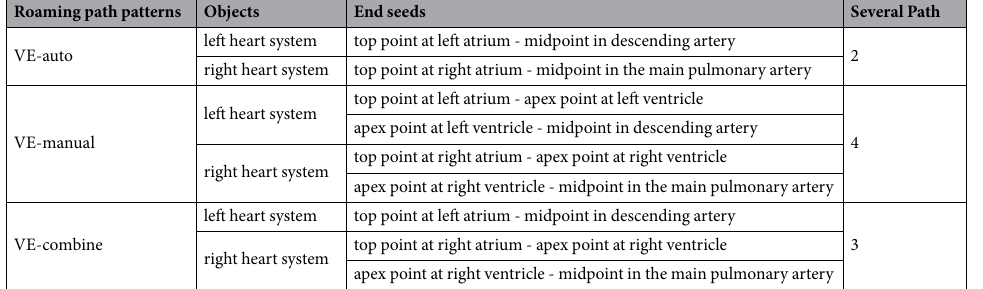
Table 2. Three roaming path patterns designed on VE in CHD